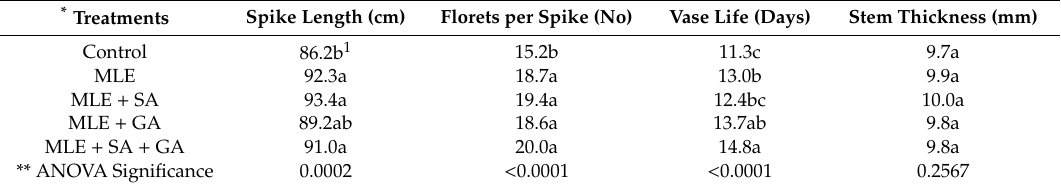
Table 4. E ff ect of corm soaking (24 h) in di ff erent treatment solutions on the ornamental traits (spike length, florets per spike and vase life) of gladiolus ( Gladiolus grandiflorus cv.